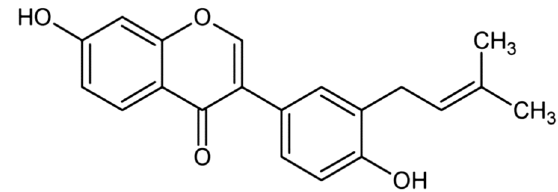
Fig. 22 Structure of neobavaisoflavone (7-hydroxy-3-[4-hydroxy-3- (3-methylbut-2-enyl) phenyl]